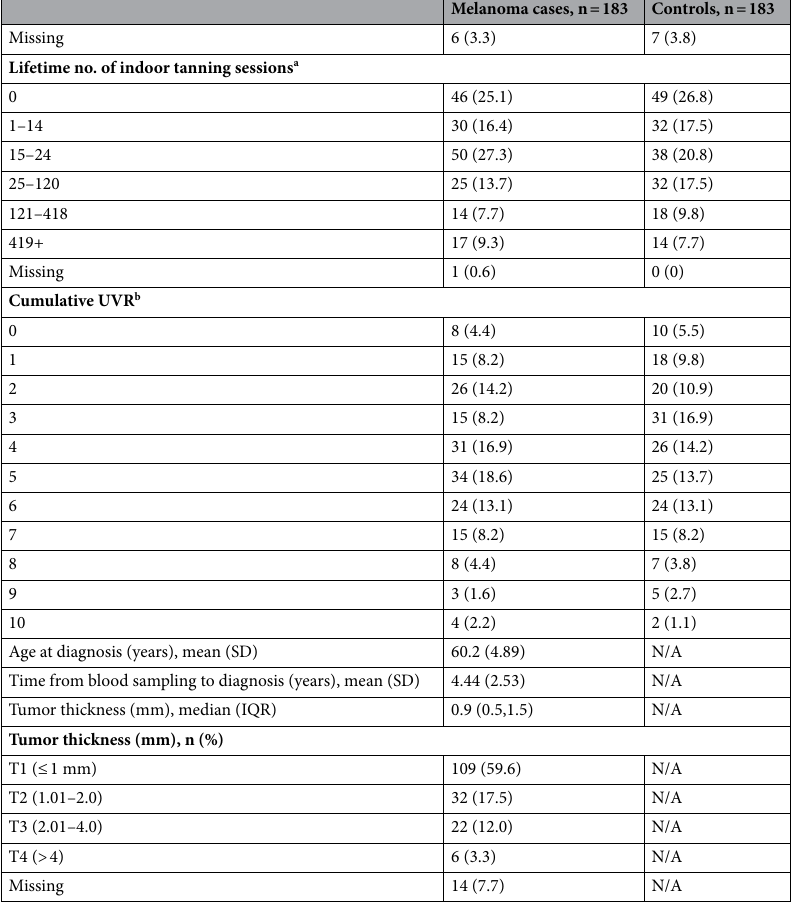
Table 1. Characteristics of the cases and their matched controls. Matched by age at blood sample and time in freezer. a Categorized in six categories: non-exposed and quartiles, with the upper quartile further divided into two equally sized groups. b Sunbathing vacations and indoor tanning.